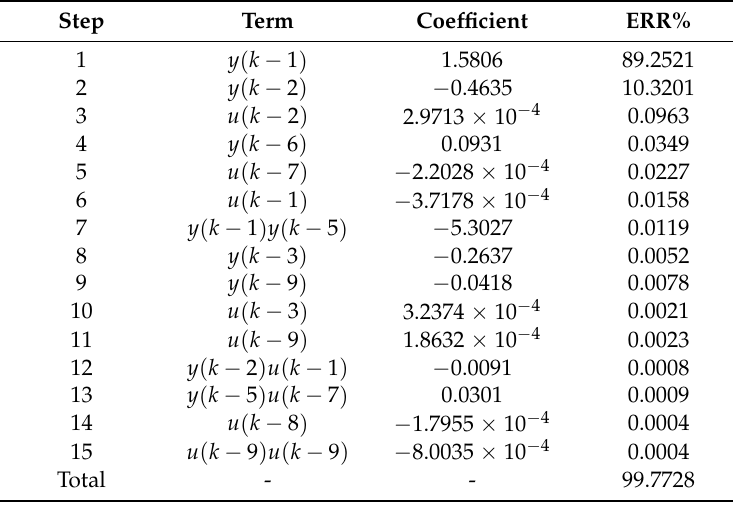
Table 1. Identification result of the